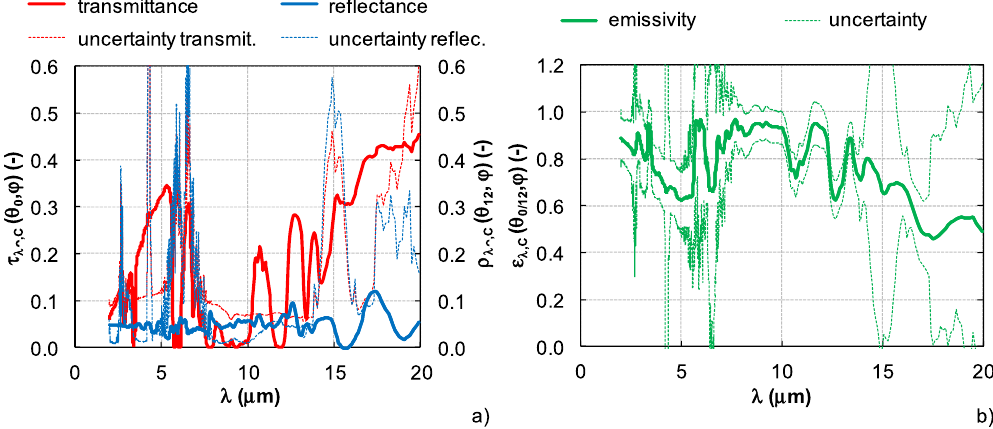
Figure 9. The results of semitransparent coating (23 μ m thickness) deposited on transparent substrate – DupliColor Aerosol Art RAL 9500/Ge substrate. ( a ) Transmittance and reflectance. ( b ) Emissivity.